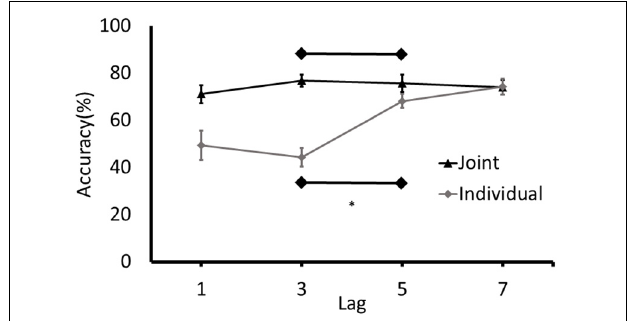
FIGURE 2 | Detection rates of T2 (% of correctly identified as a function of the targets presented) for Experiment 1. Error bars represent standard error of the mean. ∗ Denotes significance at p <